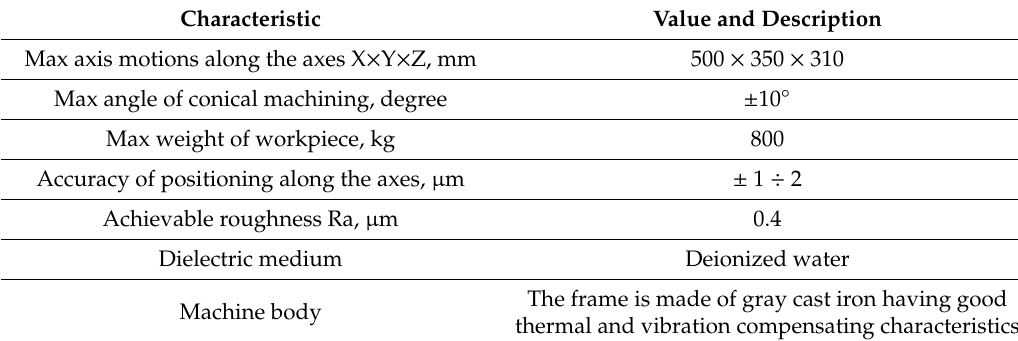
Table 1. Main characteristics of wire electrical discharge machines used in